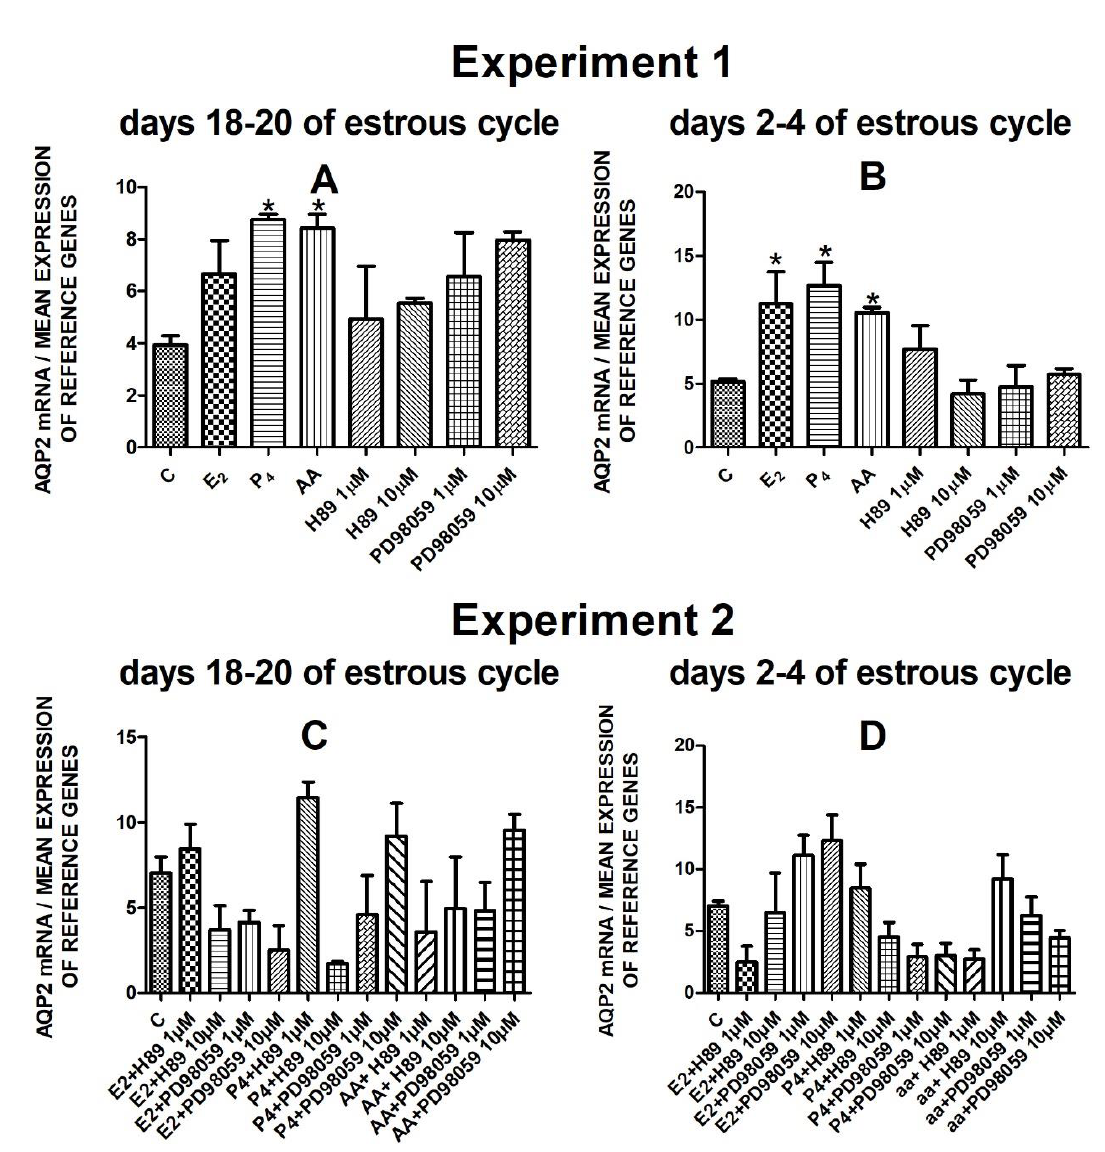
Figure 2. The influence of estradiol (10 nM), progesterone (10 − 6 M), arachidonic acid (10 − 5 M), and kinase inhibitors H89 (1 µ M, 10 µ M) and PD98059 (1 µ M, 10 µ M) and mix of these factors on Aquaporin 2 mRNA expression (Experiment 1: ( A , B ), Experiment 2: ( C , D )) in the porcine luminal epithelial cells from days 18–20 and 2–4 of the estrous cycle. The gene expression was determined by quantitative real-time PCR. Results are reported as the means ± S.E.M. ( n = 5). Bars with different superscripts differ ( p < 0.05) and are marked by (*).